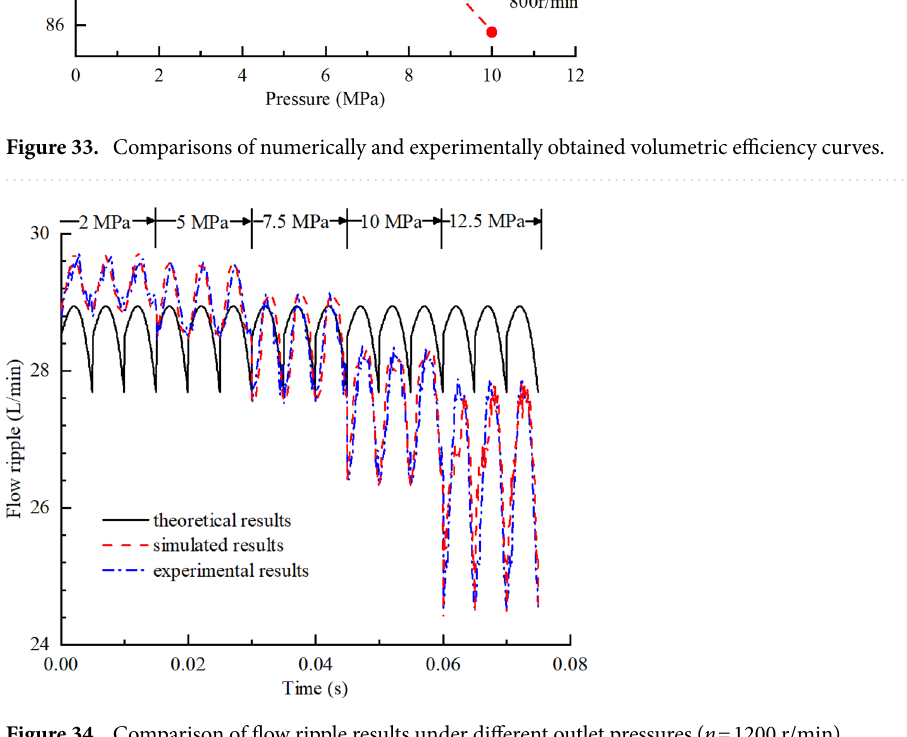
Figure 34. Comparison of flow ripple results under different outlet pressures ( n = 1200 r/min).